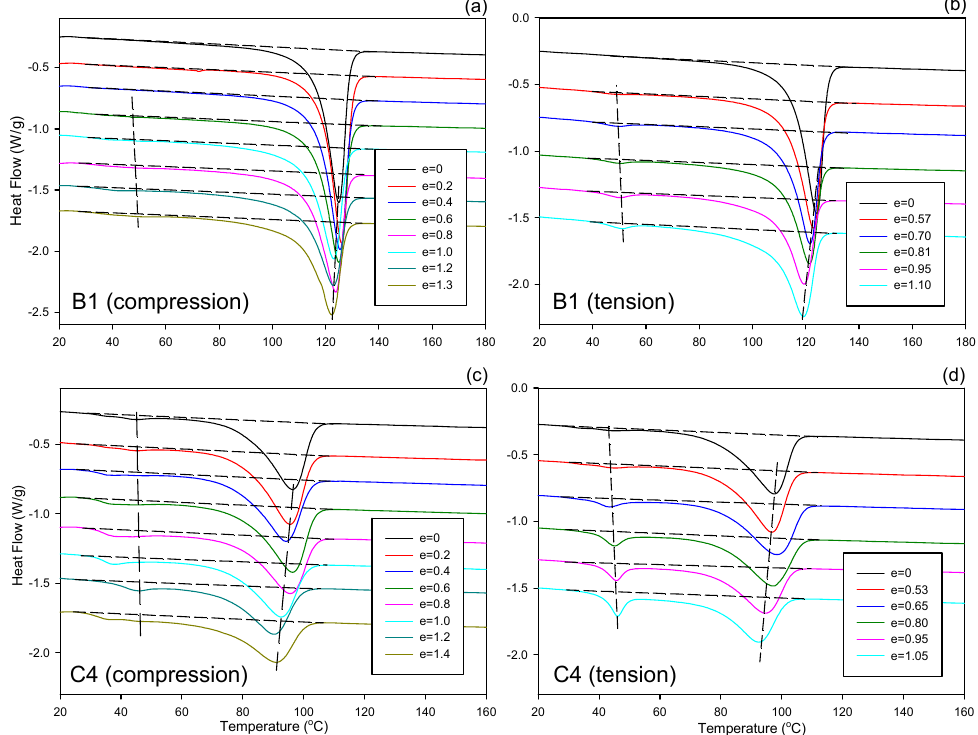
Figure 3. DSC melting thermograms of the deformed samples of B1 ( a , b ), representative for homopolymers and copolymer of low ethylene content (B1, B2, C1); and of C4 ( c , d ), representative for copolymers of high ethylene content (C4, C10). Curves in ( a , c ) represent samples deformed in compression, while those in ( b , d ) represent samples deformed in tension. The strains indicated in the plots.